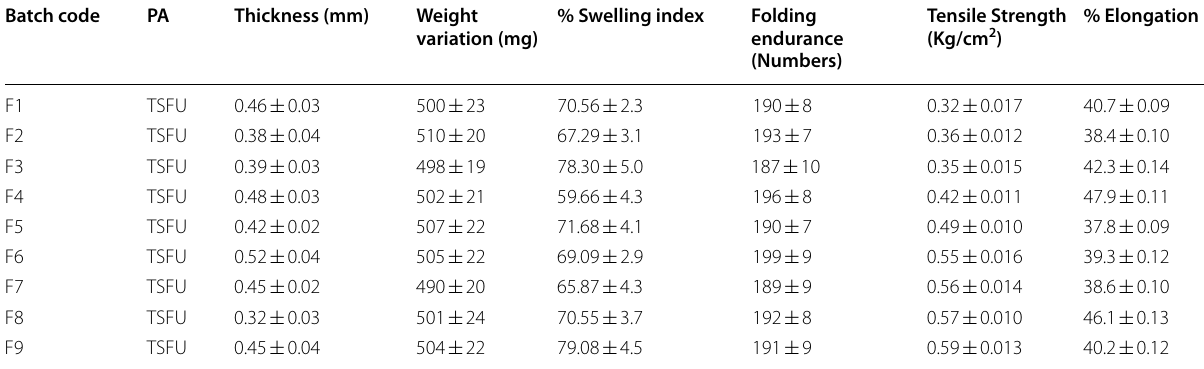
Values are shown as mean